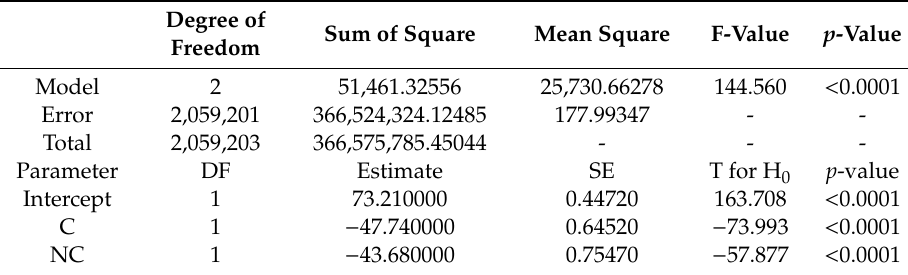
Table 11. Covariance analysis test for